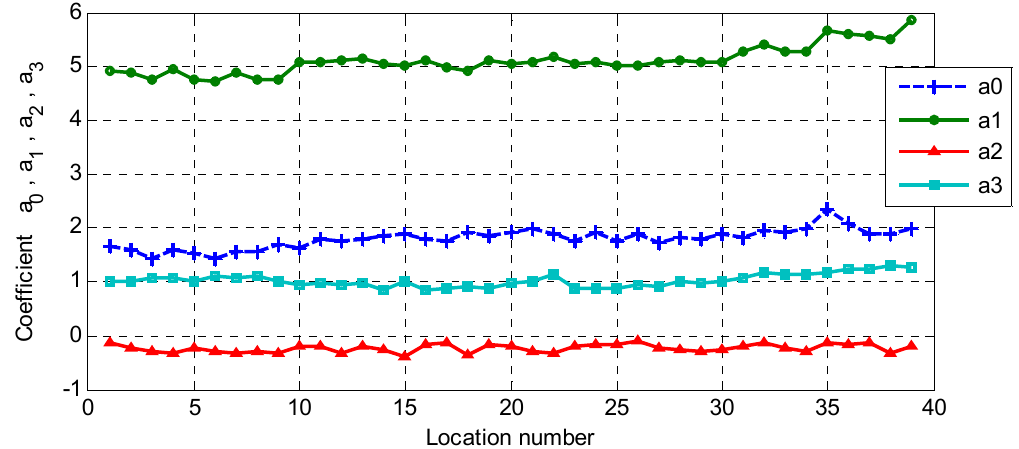
Figure 10. Model parameters for mean and standard deviation across Hs bin range to model log-normal distribution of peak period Tp -per location.